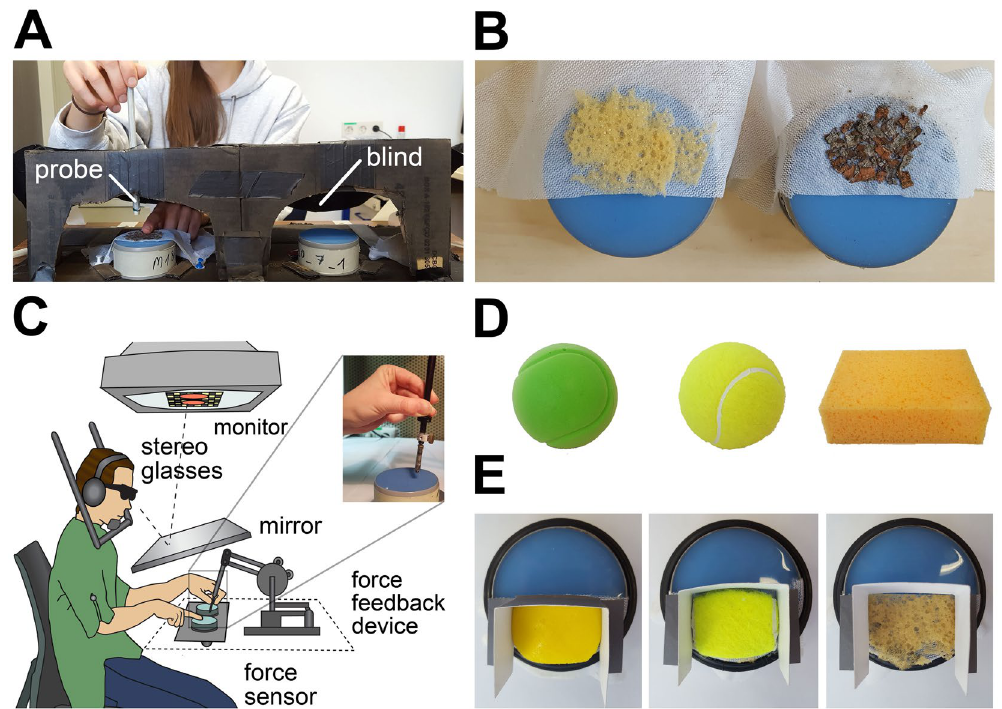
Figure 1. Setup and stimuli. (A) Setup of Experiments 1, 2 and 4. Participants sat in front of the experimenter. They made lateral strokes with the index finger to explore the surfaces of the stimuli and indented them then with a probe. A cardboard box with a blind prevented participants from seeing the stimuli. (B) Stimuli Experiment 1. Silicone rubber disks were partly covered with thin layers of bark (wood condition) or sponge glued onto elastic cloth. (C) Setup Experiment 3. Participants sat at a visuo-haptic workbench. Exploration of the stimuli was as in Experiments 1, 2 and 4. The probe was connected to a PHANToM force feedback device (for details about this setup see 41 ). (D) Tennis ball and sponge used for the covers in Experiments 2 and 4 and foam ball used for the cover in Experiment 3. (E) Stimuli in Experiments 2–4. Silicone rubber stimuli were covered with pieces of foam, or a tennis ball, or a slice of a sponge in Experiment 3. The foam ball cover was not used in Experiments 2 and